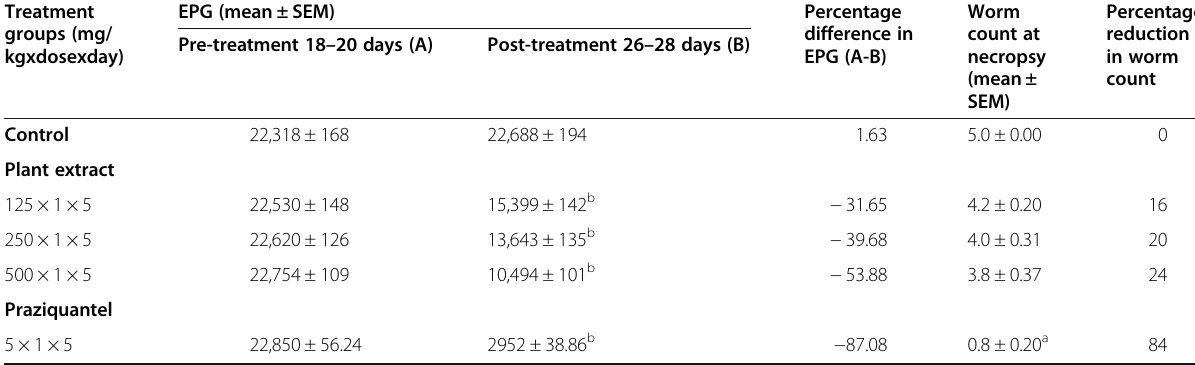
Table 1 In vivo anthelmintic effects of A. racemosus root extract* on H. diminuta infections in rats ( n = 5) Treatment groups